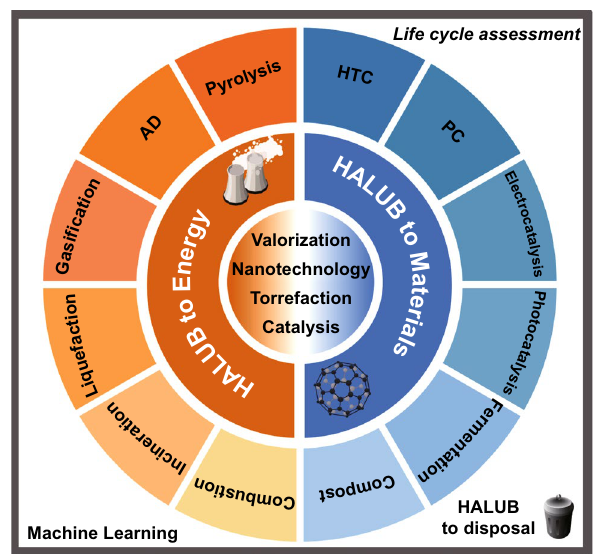
Fig. 2 Promising technologies for HALUB conversion to energy and materials